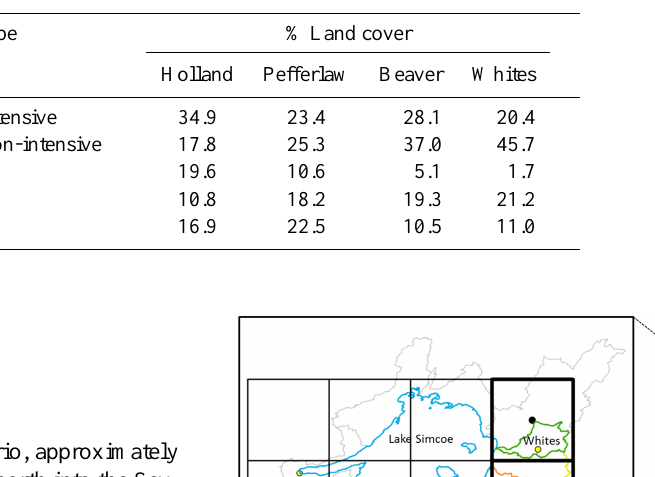
Table 1. Land use cover of the four study catchments within the Lake Simcoe catchment reported to 1 decimal place (1d.p.).